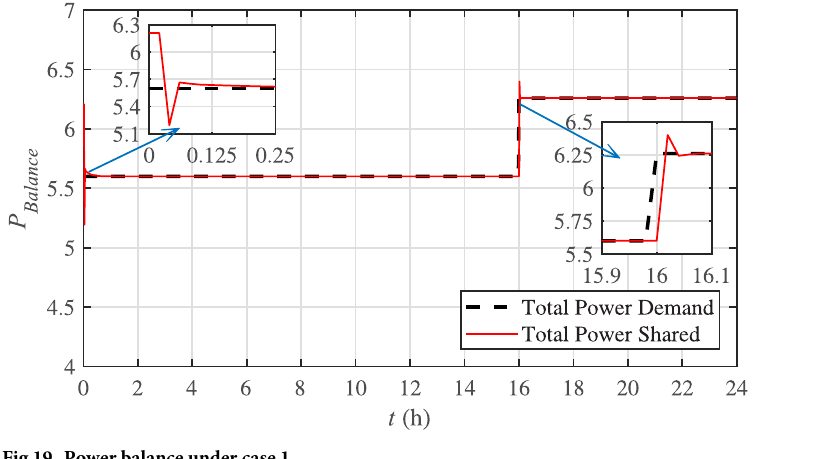
Fig 19. Power balance under case